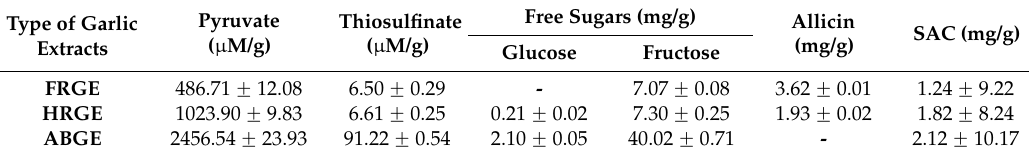
Table 1. Chemical components in garlic extracts.